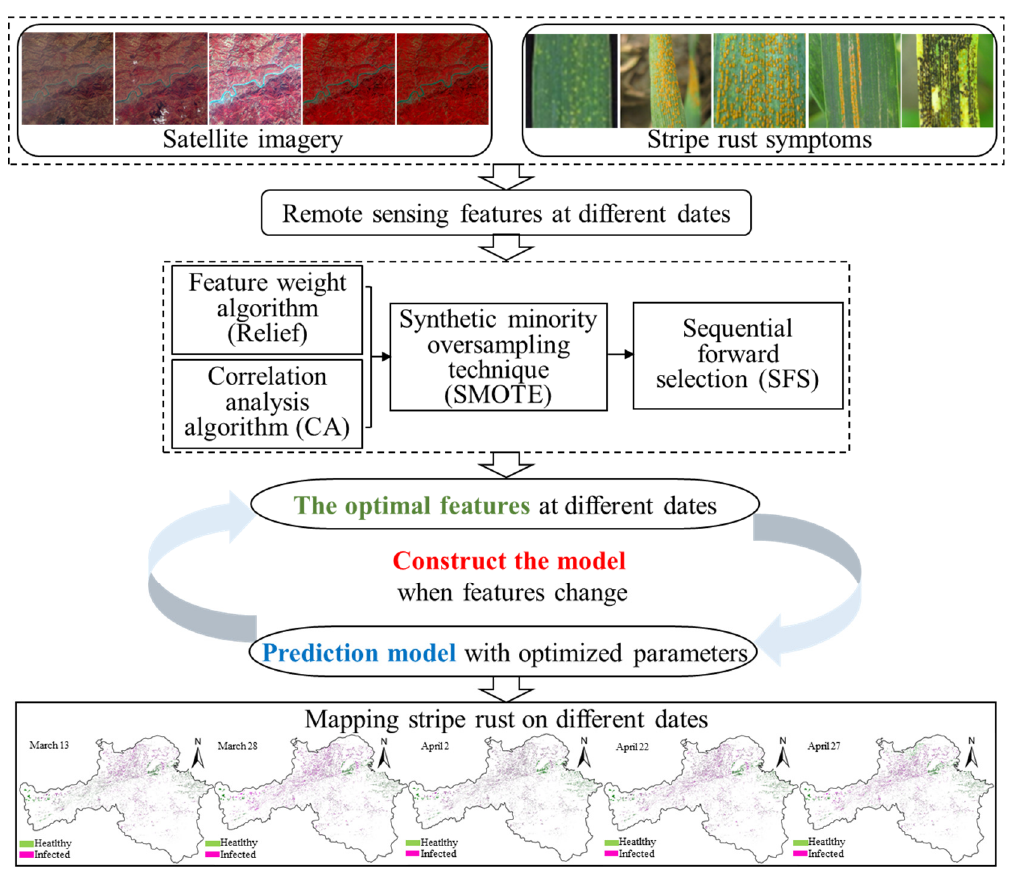
Figure 2. Flowchart of the establishment process of the prediction model for wheat stripe rust using time series Sentinel- 2 images.